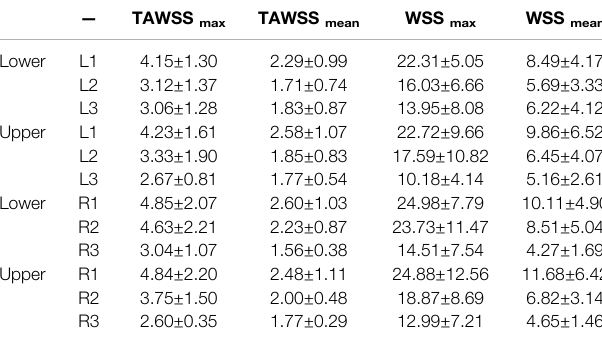
TABLE 3 | Mean wall shear stress (WSS) parameters ( ± standard deviation) in anatomical regions around the aneurysm (averaged over 10 patients). All values are in Pascals (Pa).